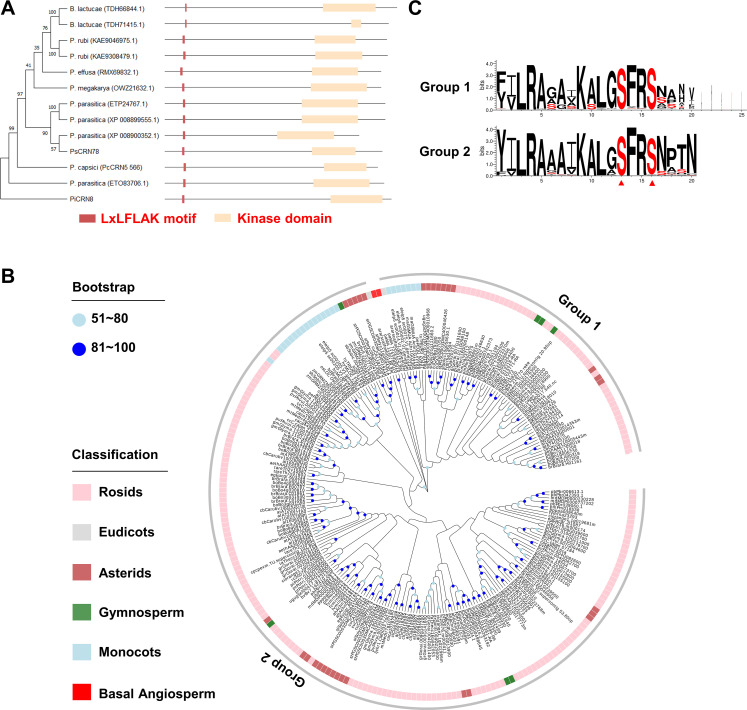
CRN78 and PIP2;2 are conserved among oomycetes and higher plants, respectively.(A) The phylogenetic tree of CRN78-like proteins. The phylogenetic tree is shown on the left. Diagram of conserved domains is shown on the right. (B) Homologous proteins of PIP2;2. The proteins were obtained by BlastP using NbPIP2;2 and GmPIP2-13 as queries (Identity > 50%, E value < 1E-5). Well-supported clades have been marked in light blue (bootstrap: 51 ~ 80) or blue (bootstrap: 81~100). (C) Conserved motif flanking the phosphorylation site of PIP proteins.